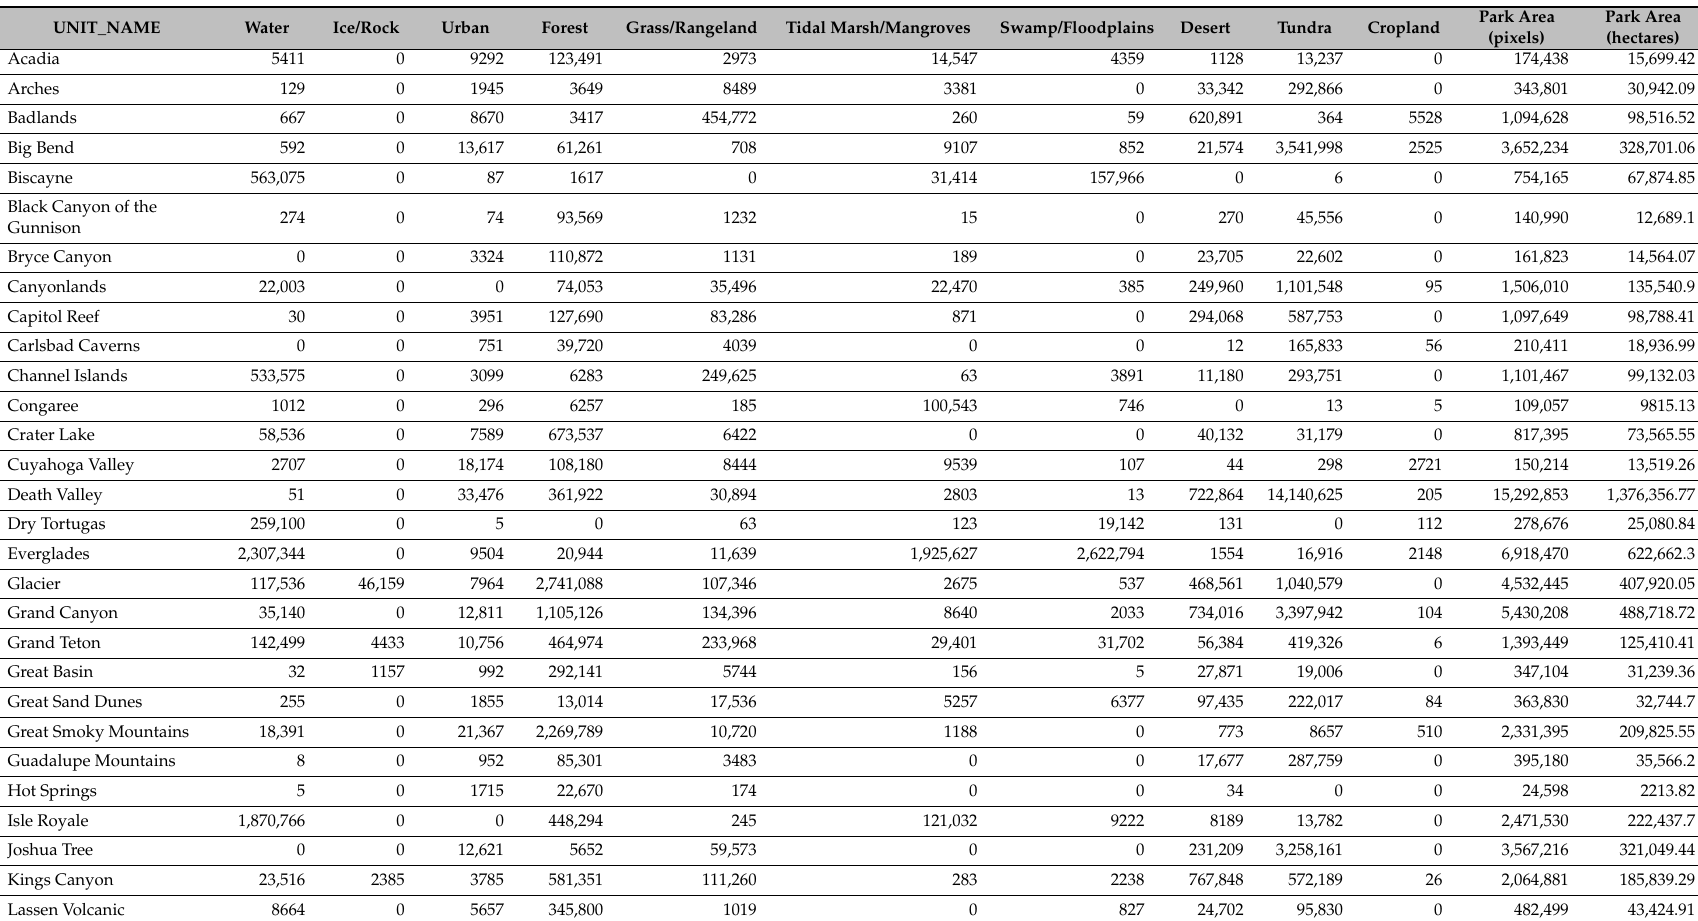
Table A1. Detailed National Park biome extent and ecosystem service